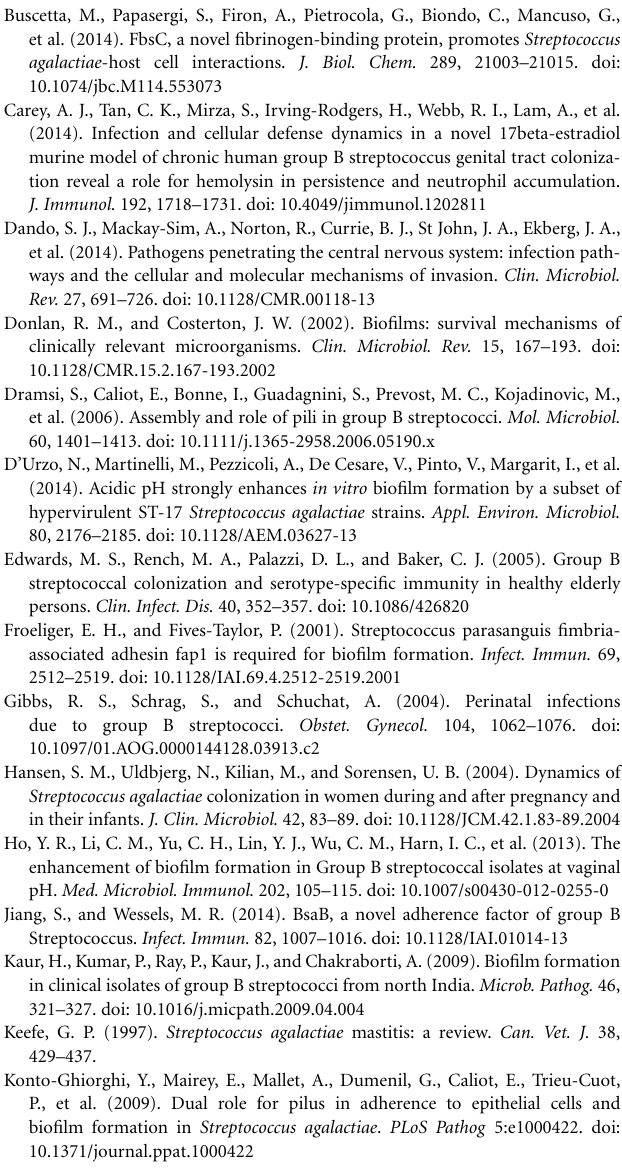
FIGURE 2 | Pilus Island-2a involvement in the formation of biofilms in vitro . Confocal scanning laser microscopy micrographs of biofilm development by GBS 515 (A) and its mutant derivative containing an in-frame